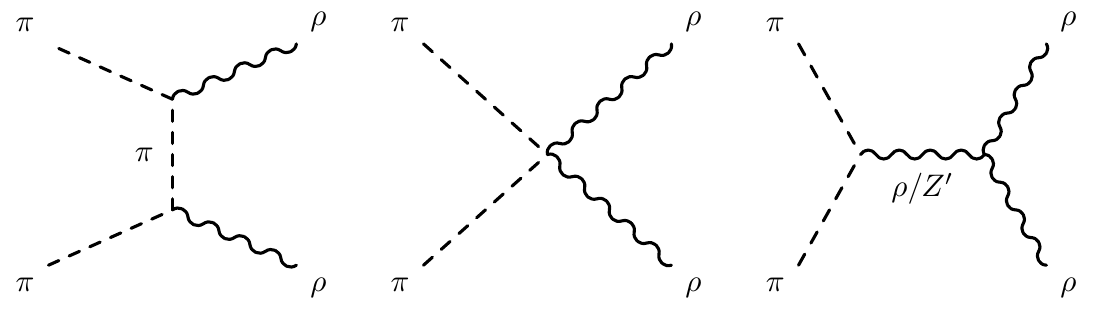
Figure 1 . Diagrams contributing to forbidden dark pion